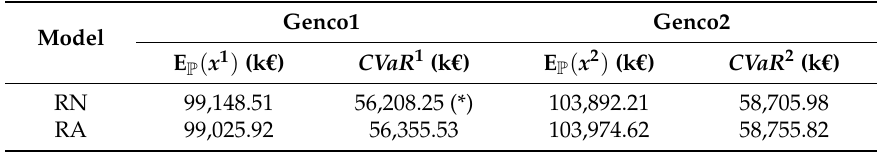
Table 4. Expected and CVaR values ( μ 1 = μ 2 = 1 )